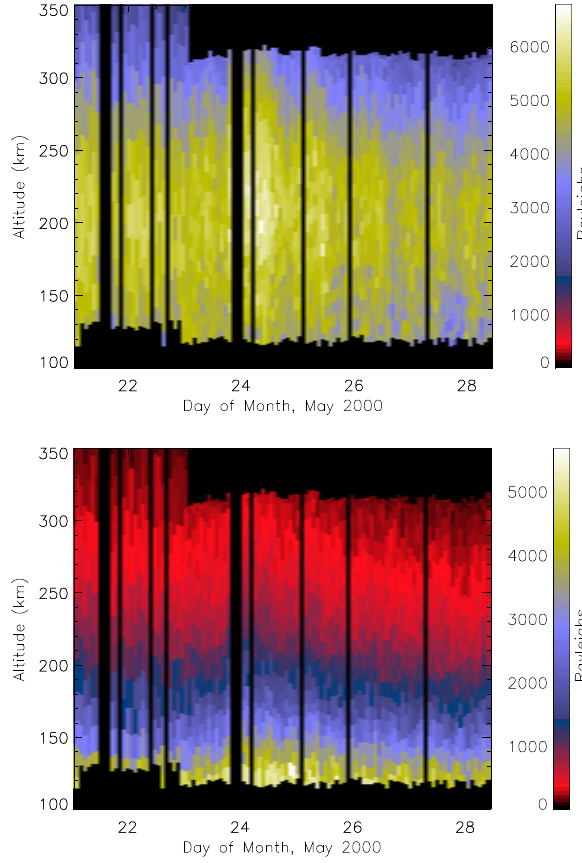
Fig. 2. Sample ISAAC spectra for data near 168km. (Top) Fit to OII 247.0nm doublet (red curves), including the N 2 VK (0,4) band (green curve) peaking near 246.4nm and the dim NO γ (0,2) band (blue curve). (Bottom) Fit to NII 214.3/213.9nm doublet (red curves), including the N 2 LBH band (green curve) visible near 212.9nm and 214.8nm and the brighter NO γ (1,0) band (blue curve) extending from 213nm to 216nm.